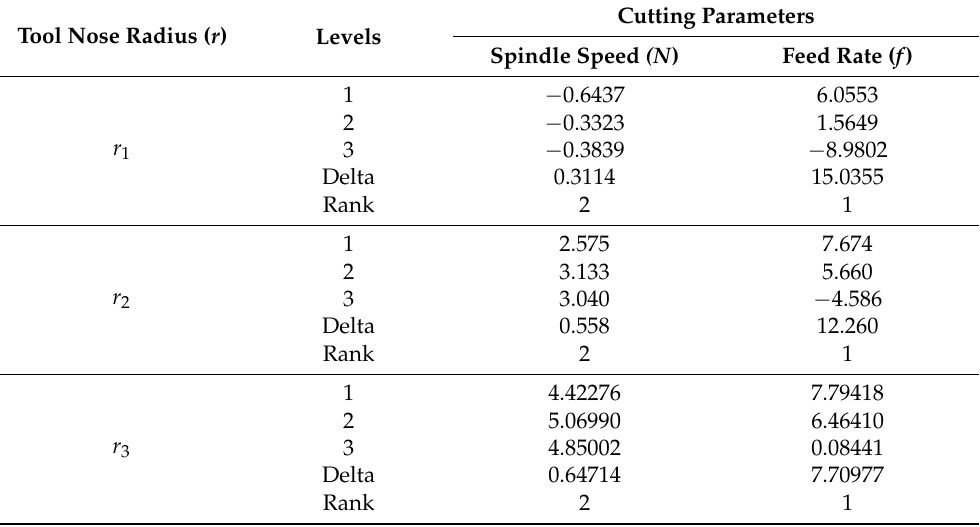
Table 5. S/N ratio response table for surface roughness (R a ) with different tool nose radius ( r ).